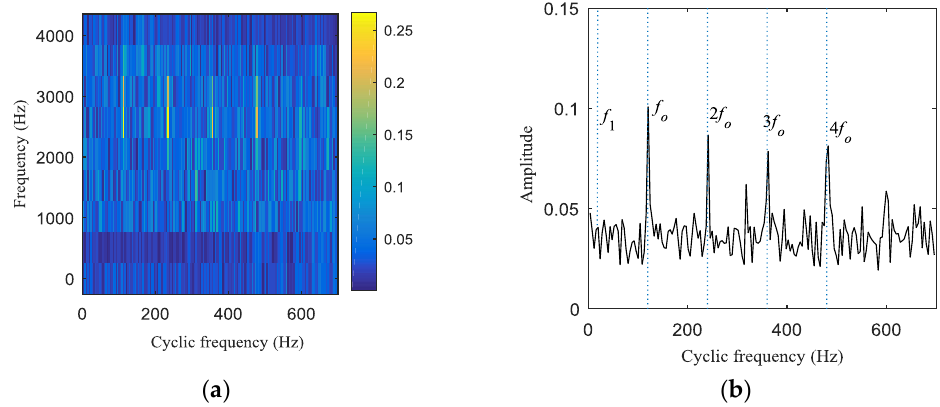
Figure 2. The processing results of x ( t ) via fast spectral correlation: ( a ) the fast spectral correlation spectrum; ( b ) the corresponding enhanced envelope spectrum.